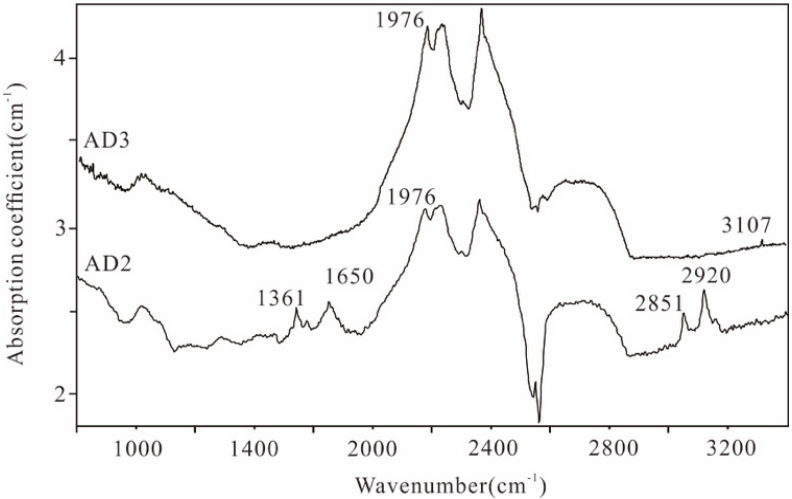
Figure 2. Infrared absorption spectrum collected from diamond AD3 and AD2.